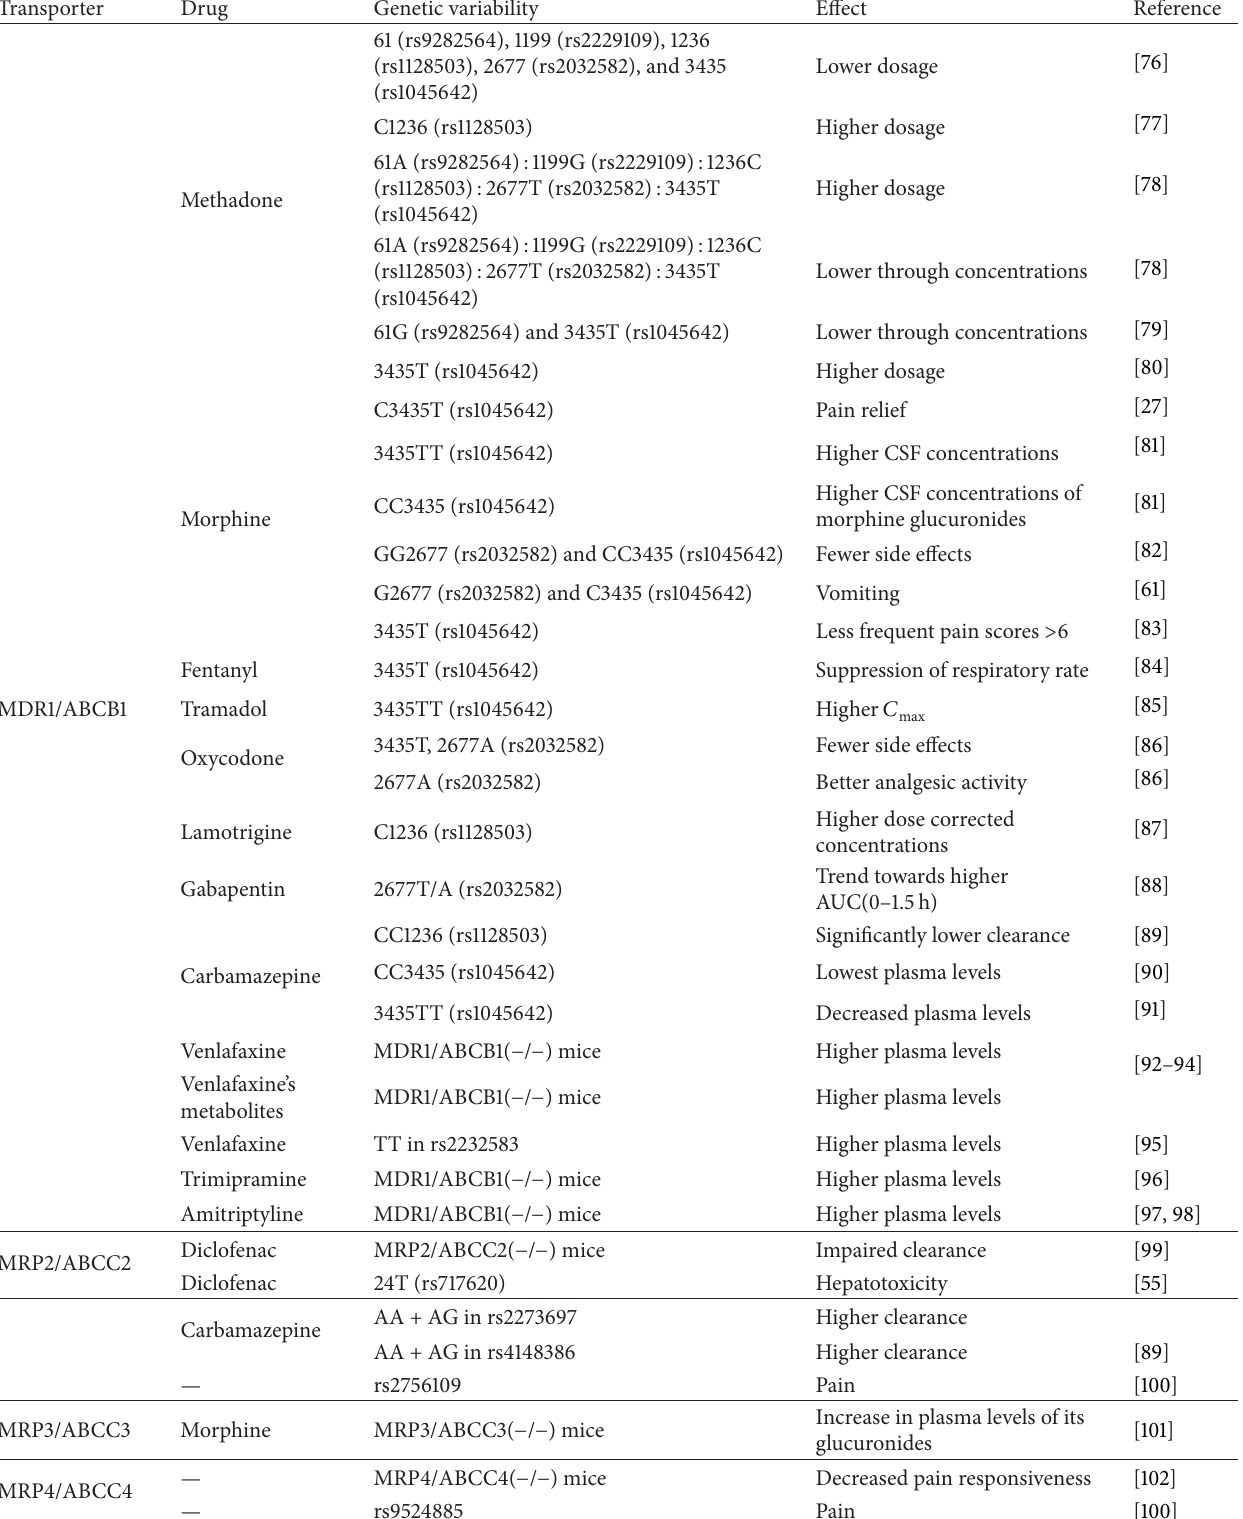
Table 6: Impact of genetic variability in genes for drug